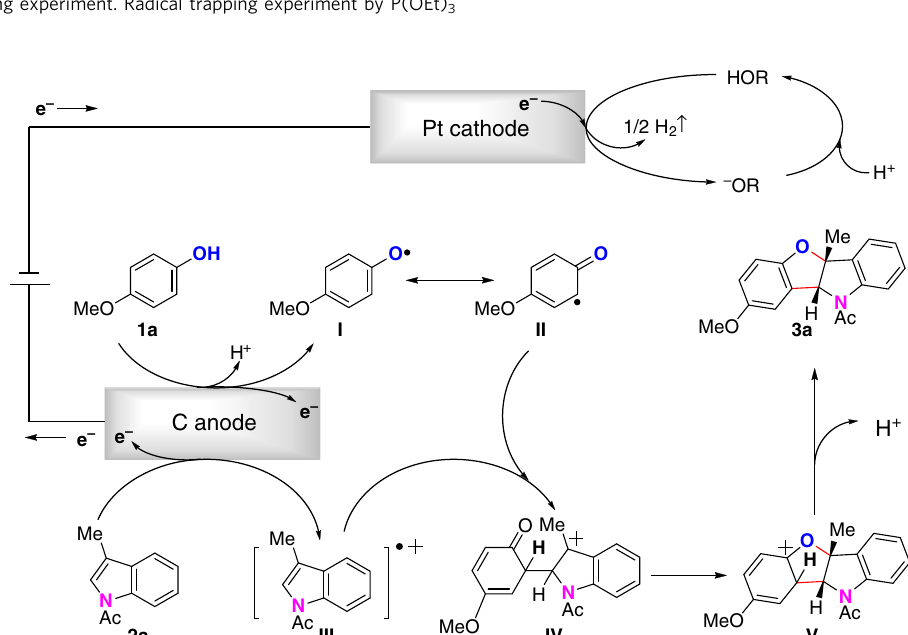
Fig. 8 Proposed reaction mechanism. Tentative reaction mechanism involves anode oxidation of phenol to generate phenol radical and N- acetylindole to generate indole cation radical, cross-coupling of phenoxy radical with indole cation radical, intramolecular cyclization and deprotonation to furnish the fi nal